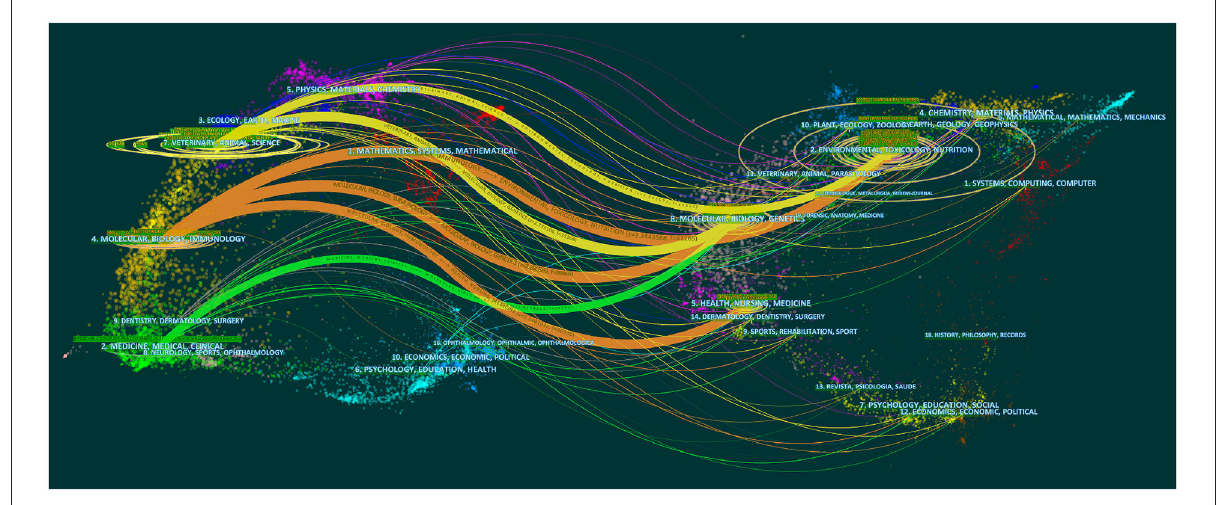
FIGURE6 Dual-map overlay of journals publishing work related to ECs and cancer (citing journals are on the left and cited journals are on the right ).